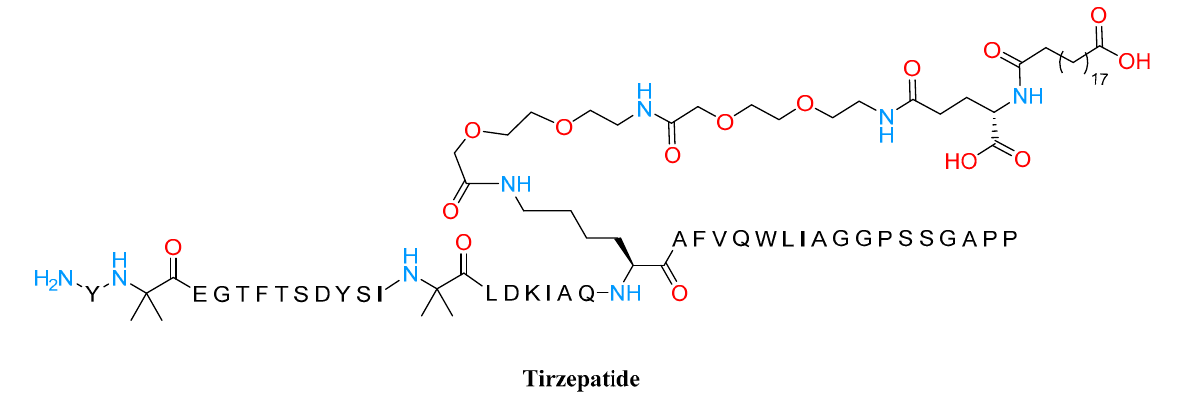
Figure 5. Structure of Tirzepatide.